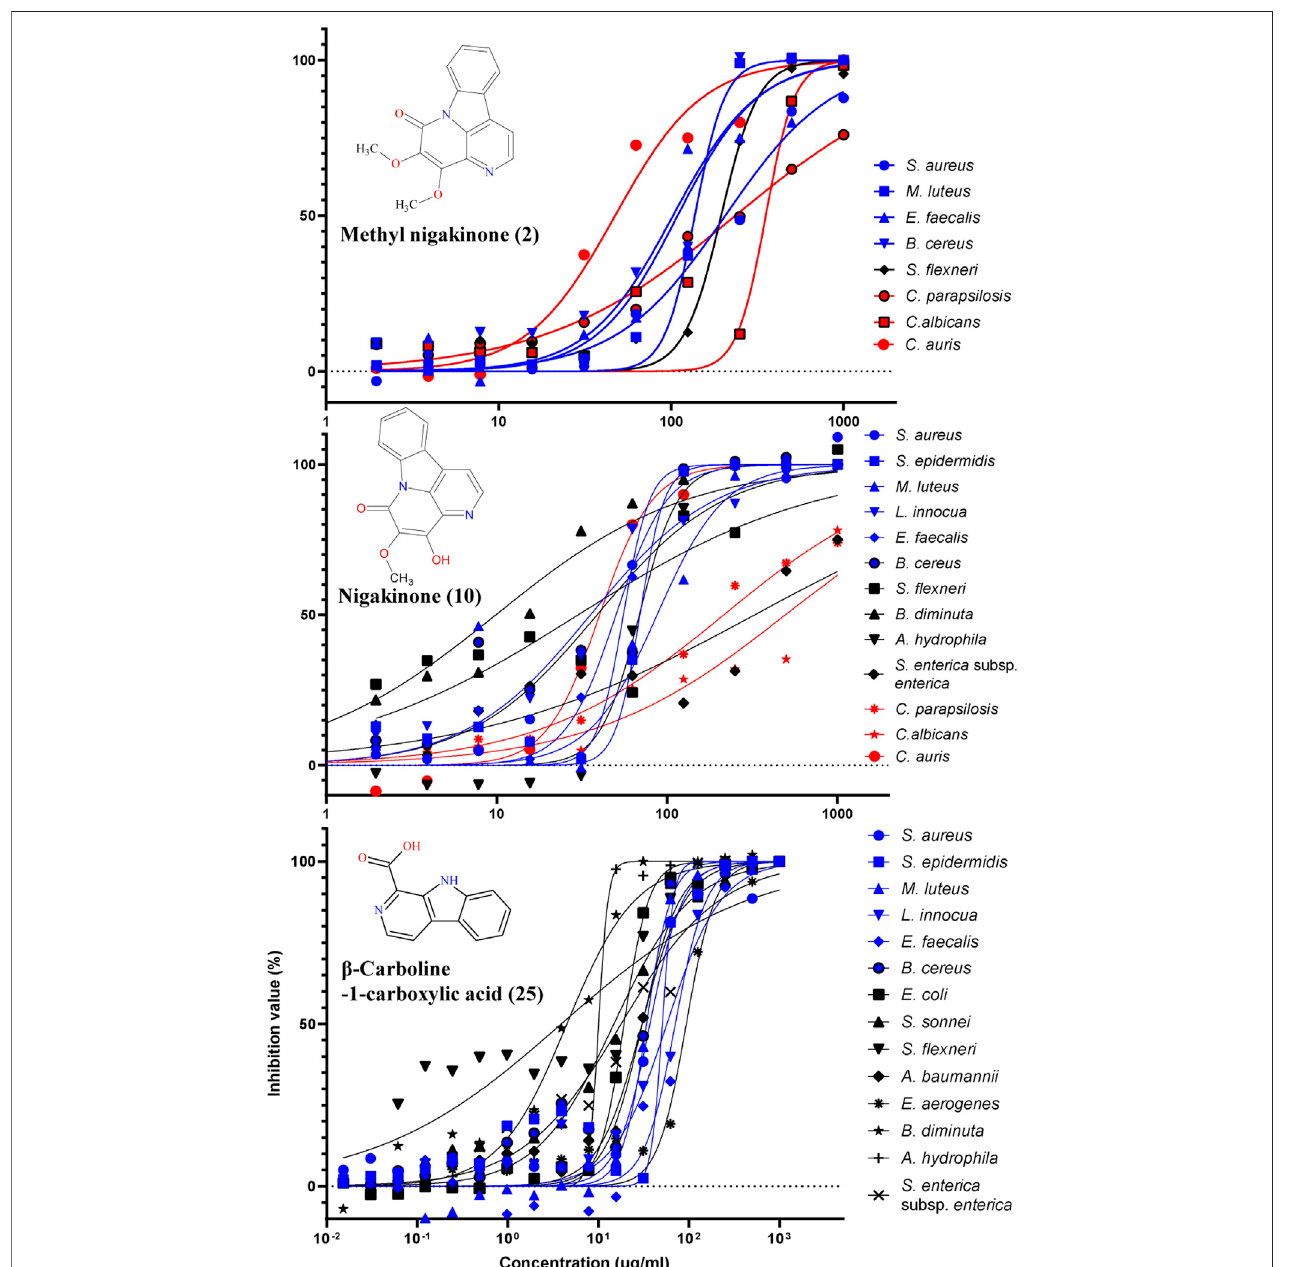
FIGURE 8 | Inhibition of different microorganisms by three β -carbolines from the stem of Picrasma quassioides .